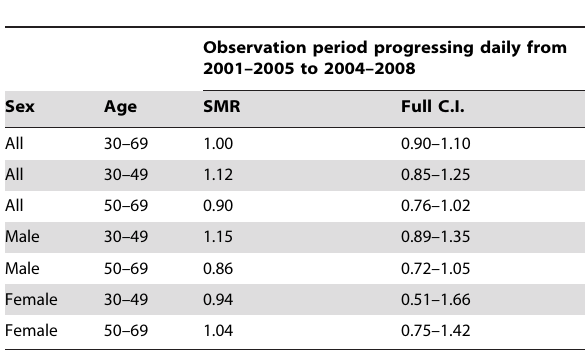
Table 4. Proposed 5-year observation period, with three years of daily